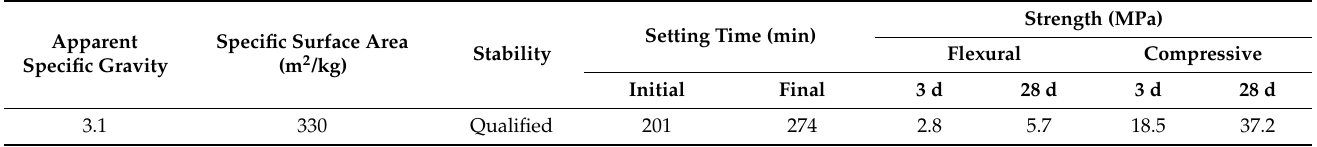
Table 1. Physical properties of P • O32.5 ordinary Portland